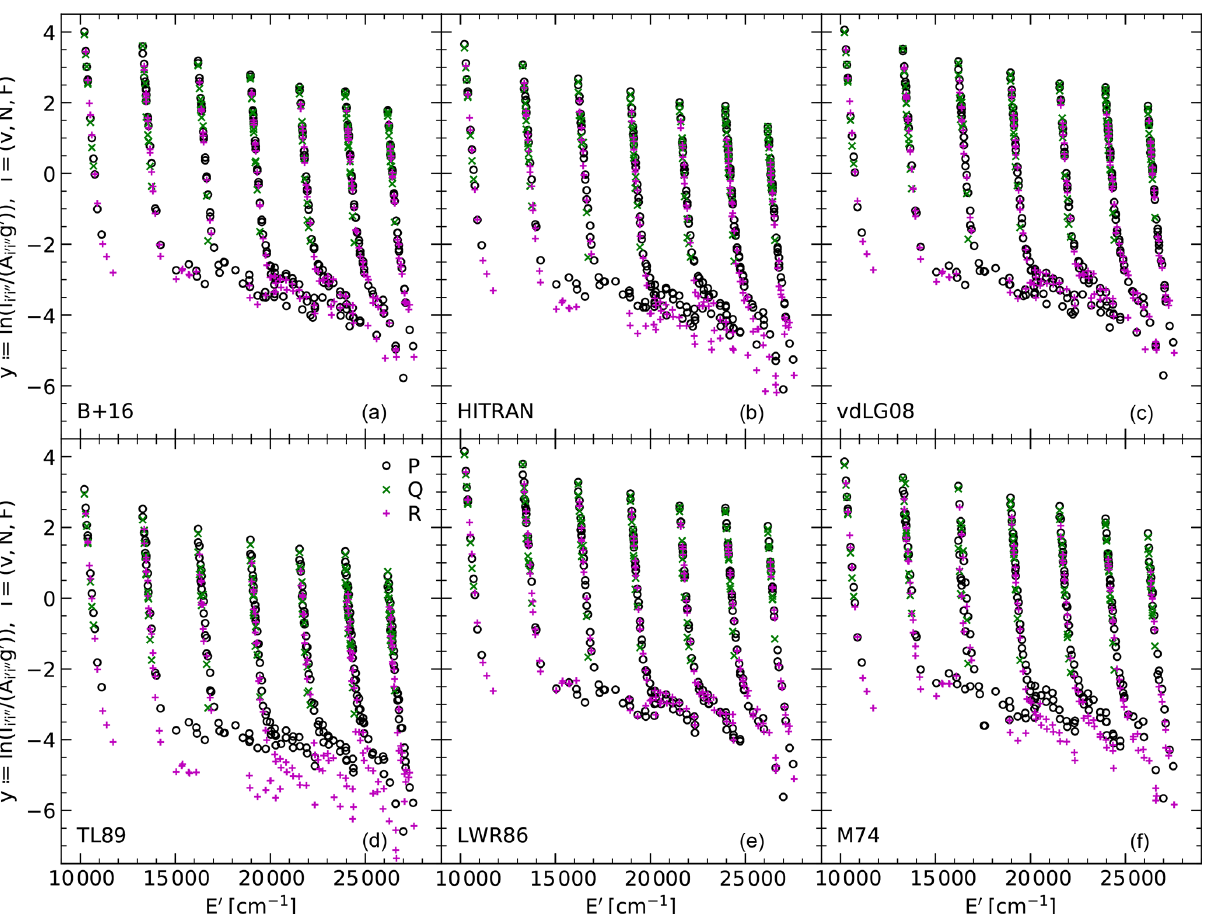
Figure 5. Distribution of logarithmic OH level populations y , i.e. line intensity in rayleighs divided by Einstein- A coefficient in inverse seconds and the statistical weight of the upper-level g (cid:48) as a function of the upper-level energy E (cid:48) in inverse centimetres. The six panels show the results for the reliable (cid:51) -doublet measurements (see Fig. 2) neglecting OH(7-1) (two lines) for different sets of Einstein- A coefficients: Brooke et al. (2016) (B+16), HITRAN (Rothman et al., 2013), van der Loo and Groenenboom (2008) (vdLG08), Turnbull and Lowe (1989) (TL89), Langhoff et al. (1986) (LWR86), and Mies (1974) (M74). The number of plotted data points is smaller for older sets due to their limitations in the coverage of faint bands and high rotational levels. The populations derived from different branches ( P , Q , and R ) are highlighted by different symbols and colours (see the legend in d